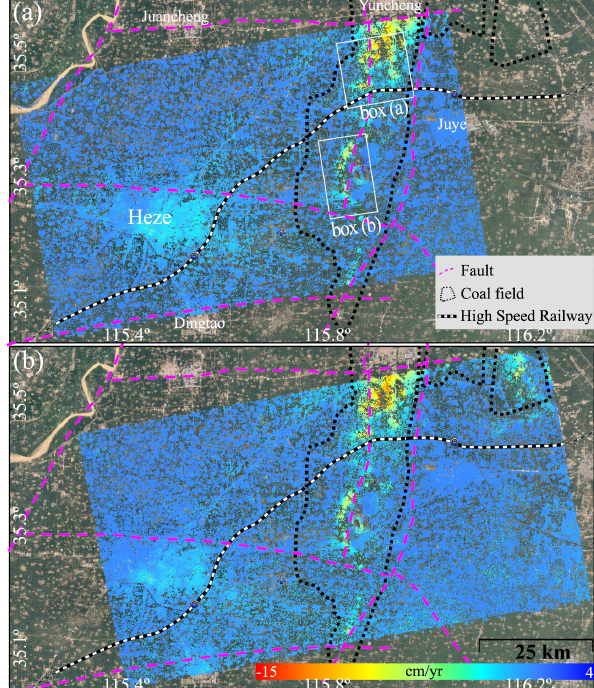
Figure 3. The average rates of land displacement results from (a) S1-40 and (b) S1-142, superimposed on a Google Earth op- tical image (© Google Maps). The two white boxes indicated by box (a) and box (b) indicate the locations of subsidence areas re- lated to underground mining, shown in Figs. 9 and 10 and analyzed in Sect.